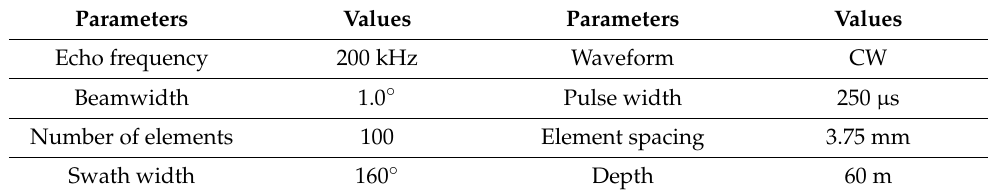
Table 2. Field experiment parameters of